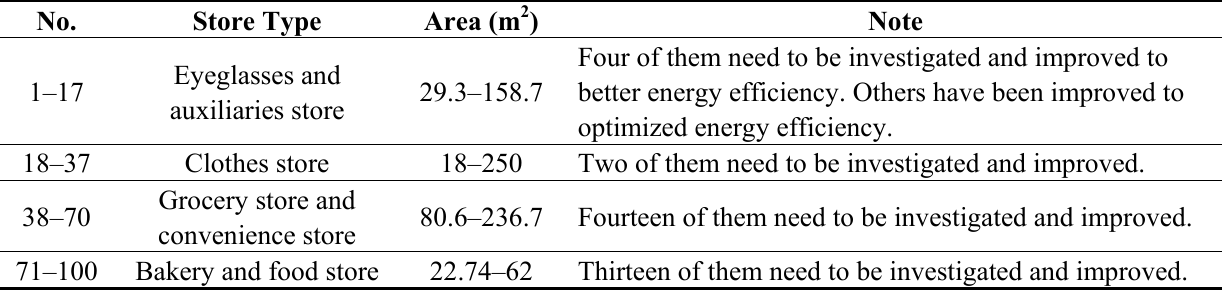
Table 1. Store list of the case study: Experiments have 100 samples in total. Among them, 67 stores have been improved to optimize their energy efficiency and 33 stores need to be investigated and